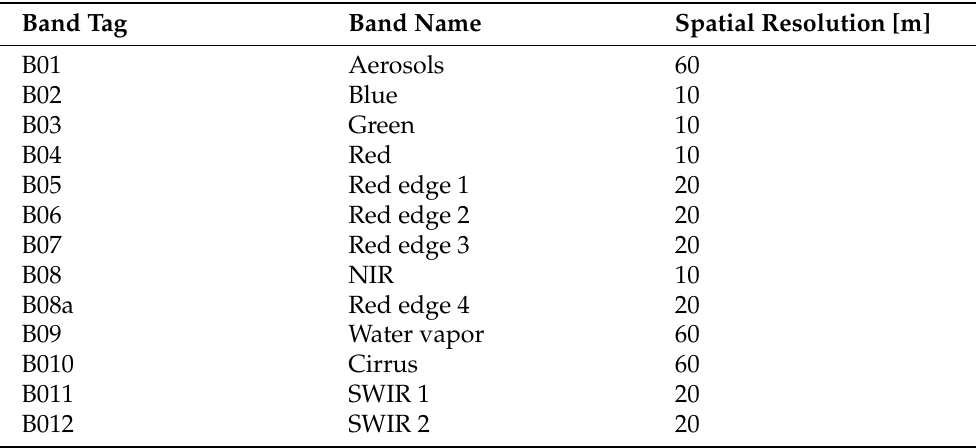
Table 1. Sentinel-2 spectral bands and their spatial